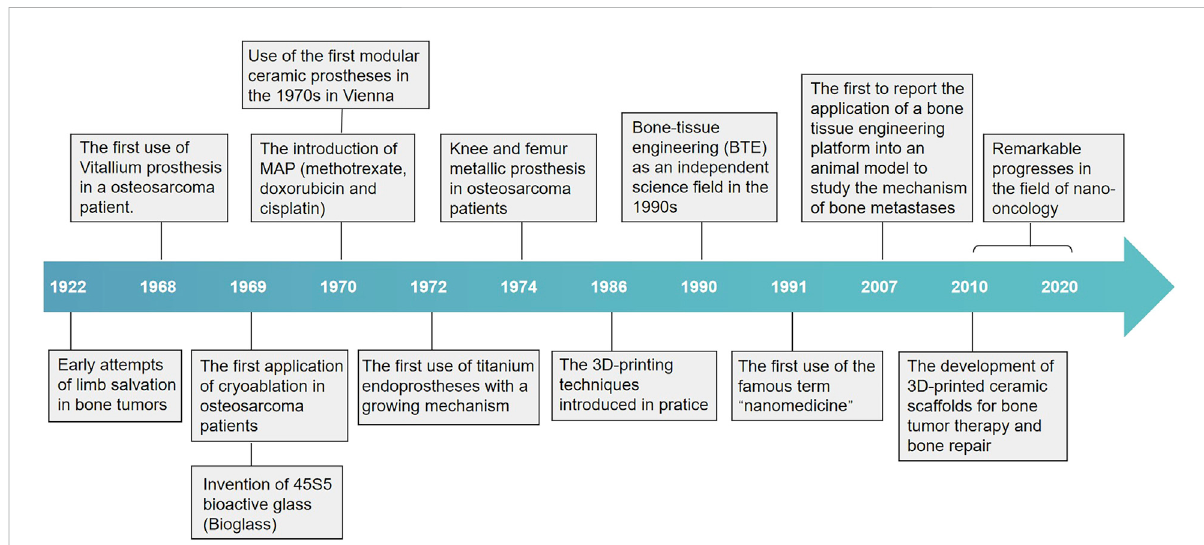
FIGURE 1 Timeline of major milestones in the development of materials for bone repair and osteosarcoma treatment. The development of materials for bonerepairbeganinthe1920swiththeuseofcalciumphosphatesandmetalsubstitutestoreplacelostboneatdefectsites.Otherformsofmaterials havebeenintroducedthroughoutthesubsequentyears,suchasbioglass andpolymermaterials,andbone-tissueengineeringeventuallyaroseasan independent fi eld. The advent of 3D printing fabrication opened the path to designing bioactive scaffolds, which are the focus in the fi eld of bone-tissue engineering. Furthermore, bone-tissue engineering has witnessed some emerging fi elds, including biomaterials science, nanotechnology,andtheirconvergencewith3Dprinting,inthelastfewyears.These fi eldshavebeendynamicallyevolvingduetourgentneedsfrom clinical